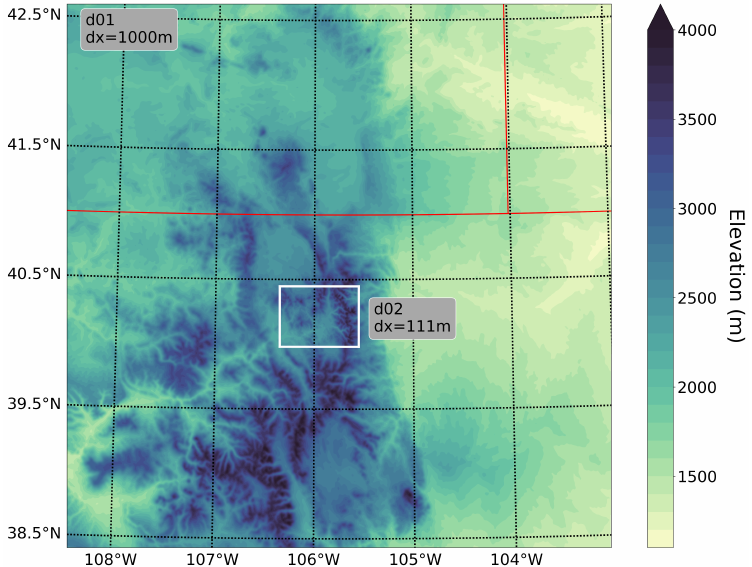
Figure 2. The two-domain setup used in the WRF-Fire simulations. Terrain elevation is color- contoured according to the color bar (units in m) and state outlines are represented by the solid red